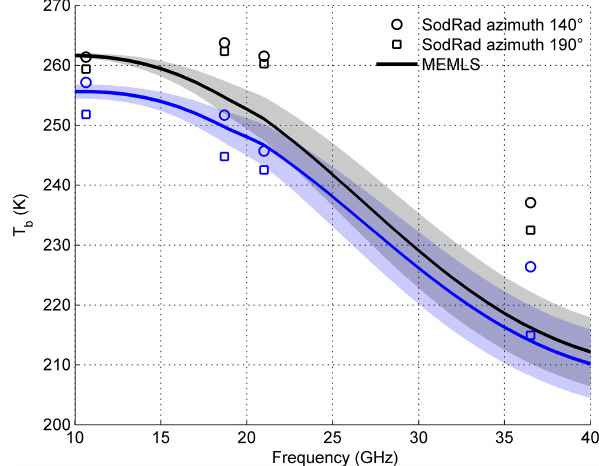
Figure 13. T b measured by SodRad at an azimuth angles of 190 ◦ (circles) and at 140 ◦ (squares). T b modeled by MEMLS from 15 SMP measurements, average (lines) with standard deviation (shaded). Colors represent polarization, with v – black and h –